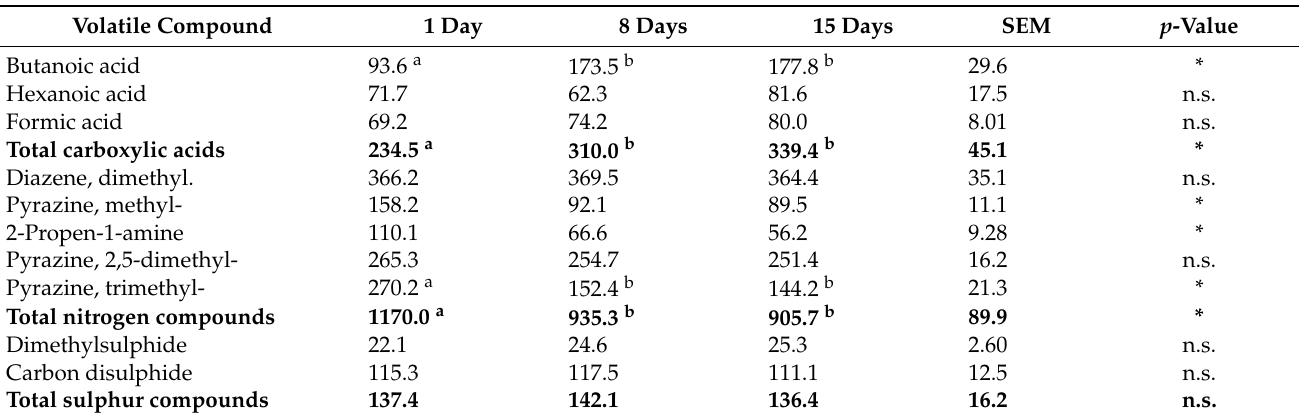
Table 6. Effects of ageing on donkey meat carboxylic acids, total nitrogen and sulphur compounds (AU × 10 3